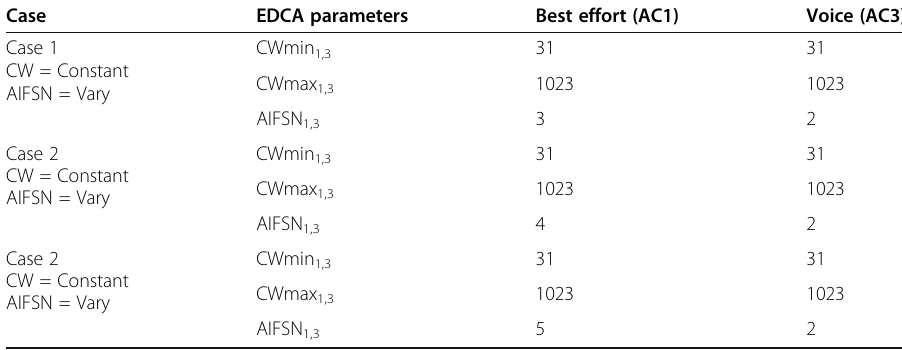
Table 4 The AIFS tuning numbers at a fixed CW size